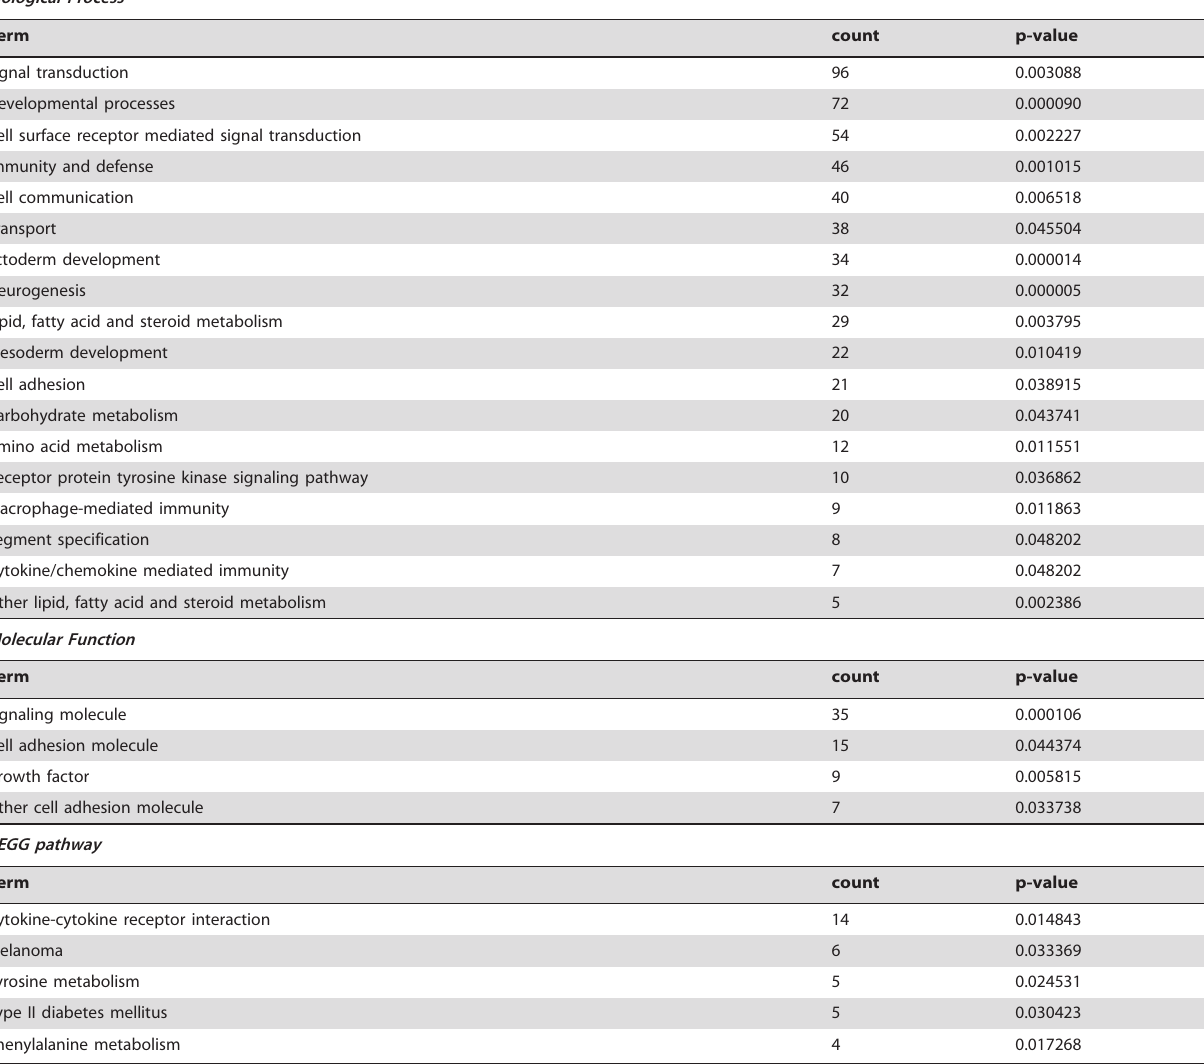
Table 1. Hypomethylation in choESC compred to